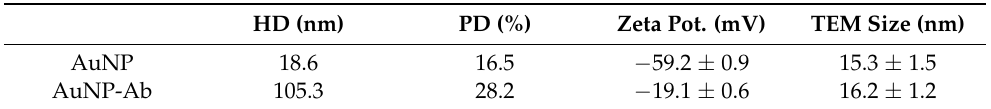
Figure 1. Physical characterizations of AuNP and AuNP-Ab conjugate. ( a ) TEM image (10,000×) before (AuNP) and ( b ) after antibody (Ab) conjugation (AuNP-Ab) (12,000×), ( c ) DLS measurement before (purple) and after (blue) antibody conjugation to AuNP, ( d ) photograph of visual color difference, before (right, red) and after (left, purple) antibody conjugation to AuNP with corresponding, ( e ) UV–vis spectra before (purple) and after (blue) Ab conjugation. Table 1. Hydrodynamic diameter (HD), polydispersity (PD), zeta potential and TEM size distribution for bare (AuNP) and conjugated